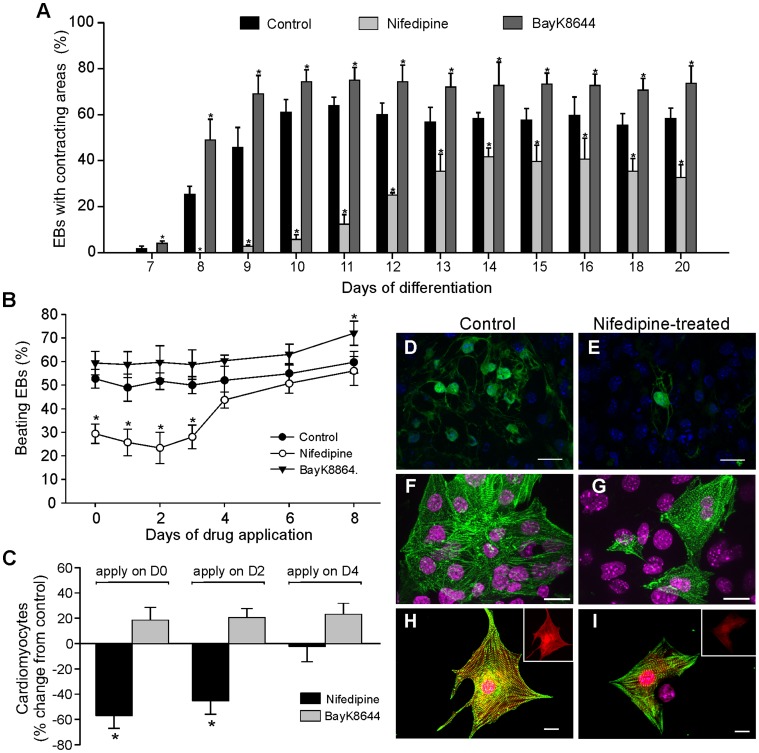
Nifedipine repressed the cardiac differentiation profile.(A) Time course of the incidence of ES cell-derived contracting EBs generated in the absence (control) or presence of nifedipine or BayK8644. The mean±SEM of the percentage of EBs with contracting areas during differentiation is depicted. (B) Percentage of beatings EBs at day 12 of differentiation derived from ES cells following nifedipine and BayK8644 administration at different times. Note that addition of nifedipine before day 4 of differentiation reduced the percentage of EBs containing beating CMs significantly below both control and BayK8644 levels. (C) Percentage of CMs changes from control condition obtained by FACS analysis after 12 days of cell differentiation under nifedipine and BayK8644. Nifedipine and Bayk8644 were applied on days 0 (D0), 2 (D2) and 4 (D4) of differentiation. (D–E) Immunofluorescence detection of CMs (green) in EBs after 12 days of differentiation. (F–G) Immunostaining of representative dispersed cells from beating clusters of EBs derived under control and nifedipine-treated conditions with anti-sarcomeric α-actinin (red) (1∶800). (H–I) Cardiomyocytes isolated from beating areas of EBs at day 12 of differentiation in both control and nifedipine-treated conditions show sarcomeric striations when stained for α-sarcomeric actinin. Insets show the fluorescence intensity of EGFP (red). Hoechst 33342 was used to stain nuclei (blue or magenta). Scale bars: 20 µm.